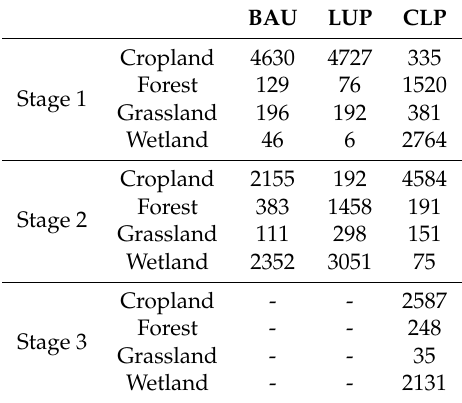
Table 7. The average change of the occupied land in different stages in each simulation of the scenarios.